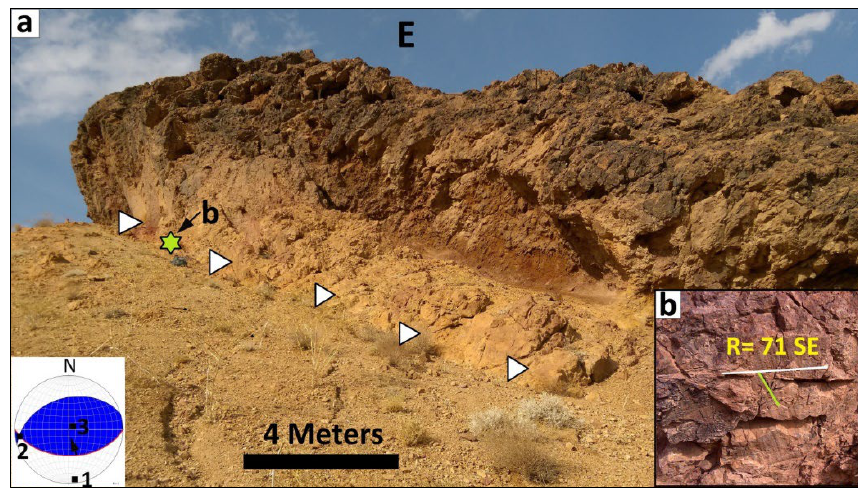
Figure 5. ( a ) Trace of the reverse, dextral component of the F1 fault (shown by triangles); ( b ) slicken line on the minor fault (the location is shown by the star). In the stereonet, the numbers 1, 2, and 3 represent the orientation of the principal stress axes, and the arrow in the stereonet indicates the direction of movement of the hanging wall.